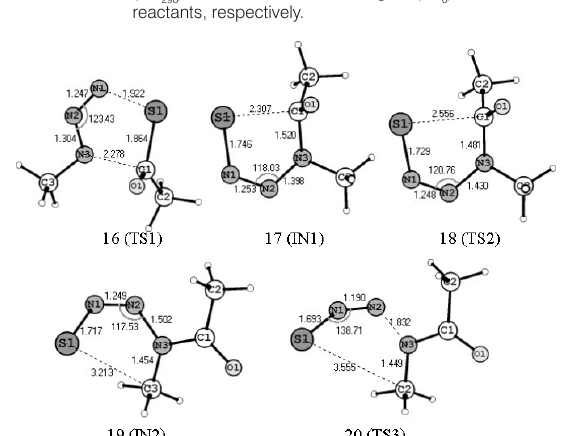
) relative to the 0